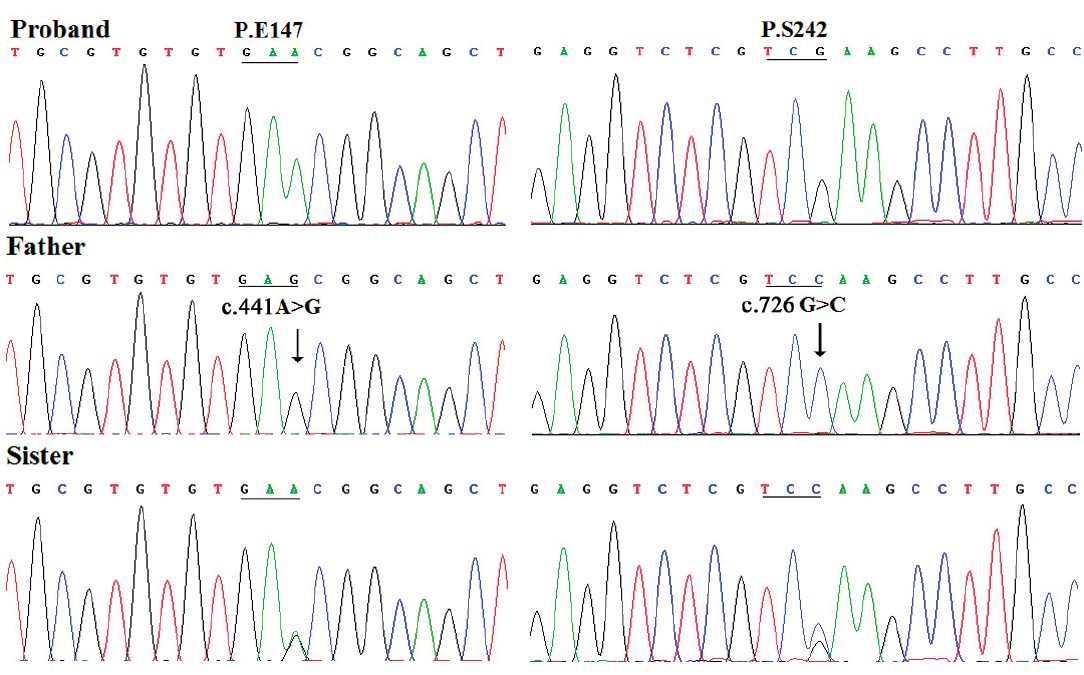
Figure 2. Chromatography of synonymous mutations of LMX1B gene in the family. The proband, his father, and elder sister, were wild type, homozygous at the 441 locus and heterozygous at the 726 locus.